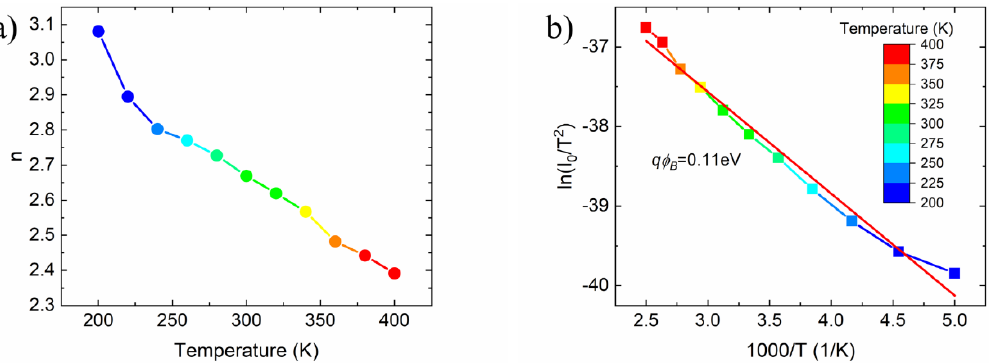
Figure 2. ( a ) Ideality factor vs the temperature extracted from the thermionic emission (T.E.) model ( b ) Richardson plot of the ln(𝐼 0 𝑇 2 ⁄ ) versus 10 3 𝑇⁄ .